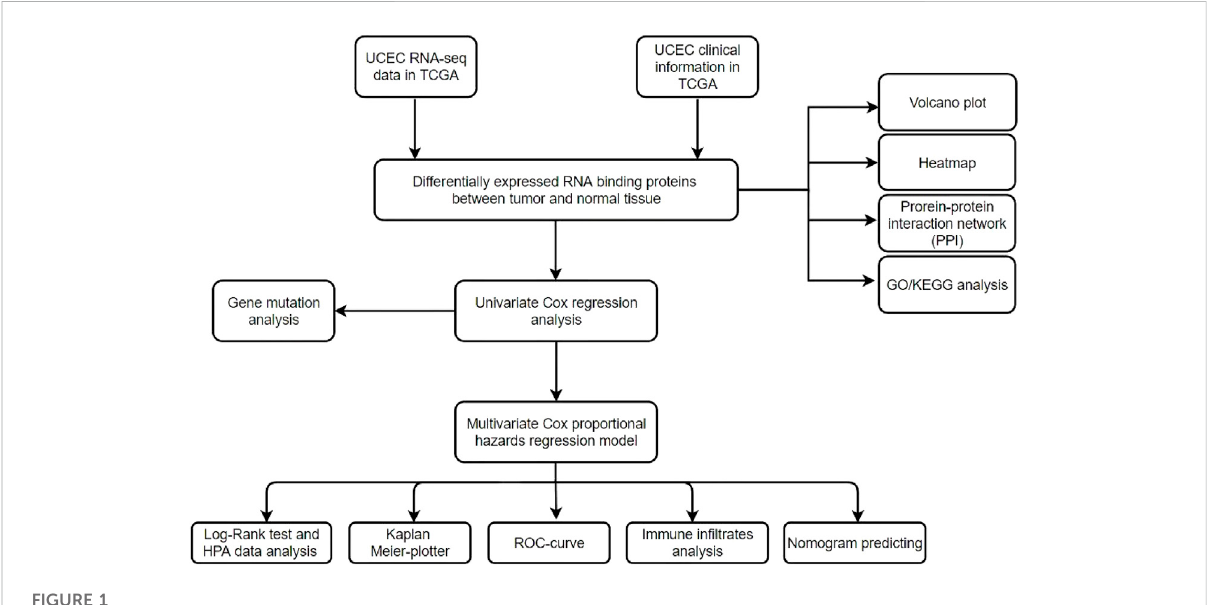
FIGURE 1 Flowchart for analyzing RBPs in UCEC.